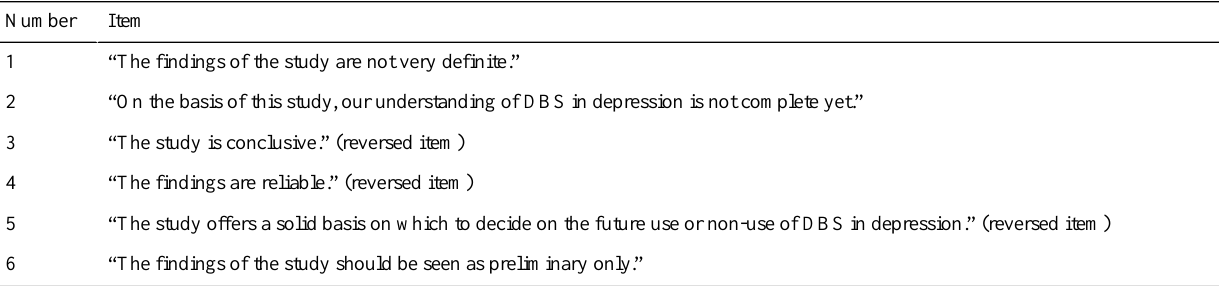
Table 2. Items measuring perceived tentativeness.